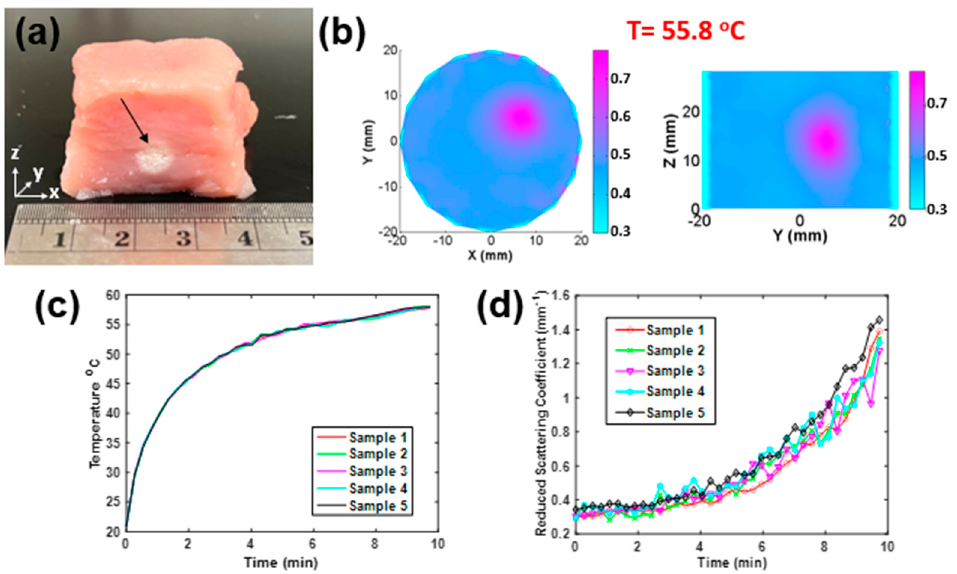
Figure 2. ( a ) Photograph of a porcine sample treated by HIFU along the z -axis. ( b ) Recovered µ (cid:48) s distribution in XY and YZ planes (t = 55.8 ◦ C). ( c ) Temperature versus time and ( d ) recovered µ (cid:48) s versus time of five porcine samples treated by HIFU in 10 min per sample.